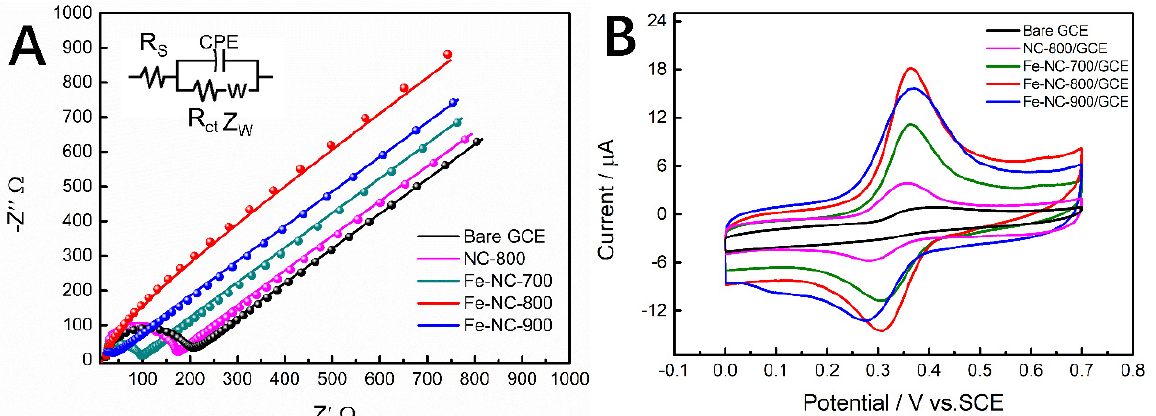
Figure 4. ( A ) Electrochemical impedance maps (EIS) of electrodes modi fi ed with di ff erent materi- ( B ) CV plots of electrodes modified with different materials in 0.1M CPB solution (pH = 6.8) containing als; ( B ) CV plots of electrodes modi fi ed with di ff erent materials in 0.1M CPB solution (pH = 6.8) 50 µ M acetaminophen, scan rate 100 containing 50 µM acetaminophen, scan rate 100 mV/s.